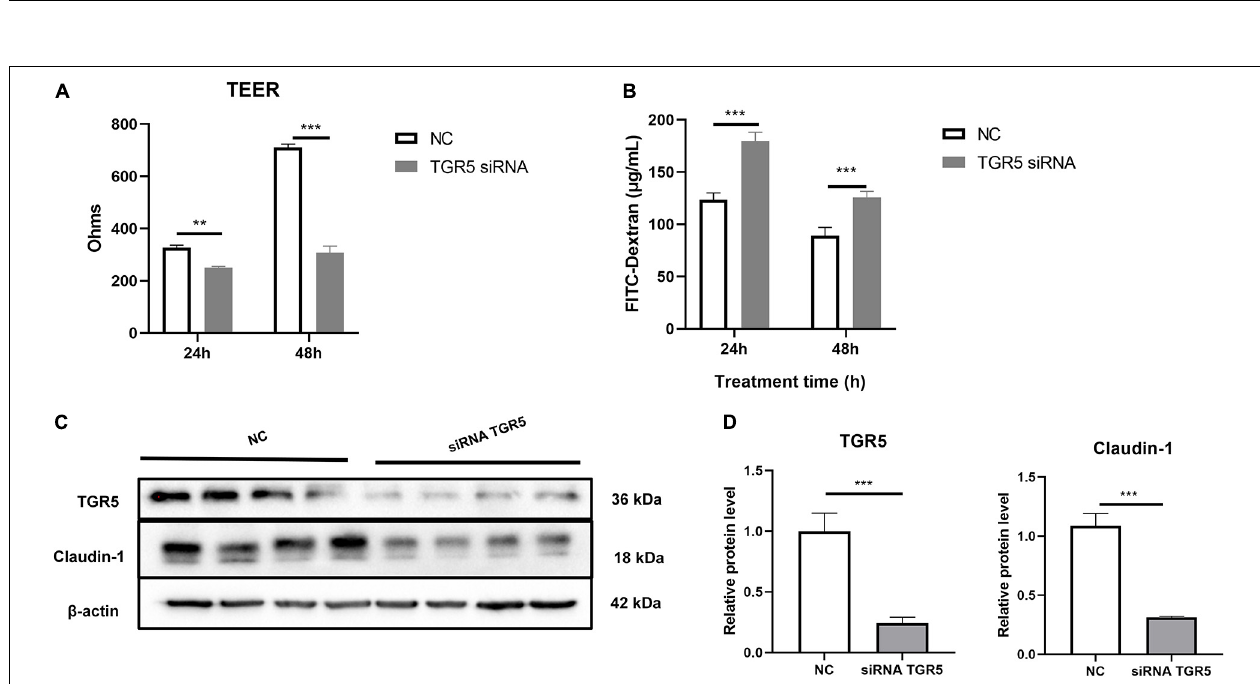
FIGURE 7 | Interference with TGR5 mRNA expression reduces Caco-2 monolayer epithelium barrier function. (A) The TEER of the cell monolayer of caco-2, n = 3. (B) The FITC-dextran permeability of the cell monolayer of Caco-2, n = 3. (C,D) Protein expression of TGR5 and Claudin-1 relative to β -actin. The results were confirmed by three independent experiments. Differences in data in cell subjects were assessed by one-way ANOVA. * p < 0.05; ** p < 0.01; *** p < 0.001.